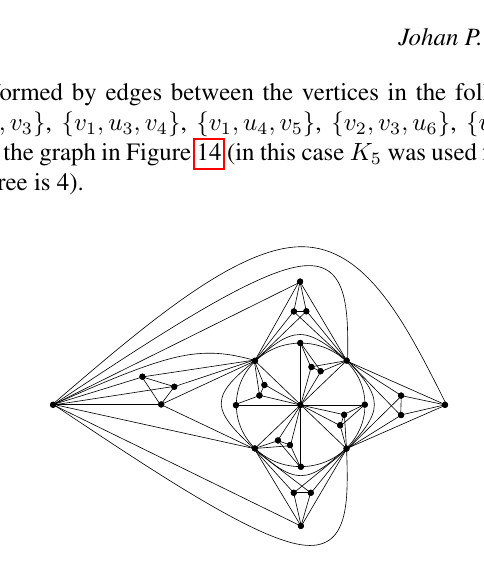
Fig. 14: A nontraceable LH graph with minimum vertex degree